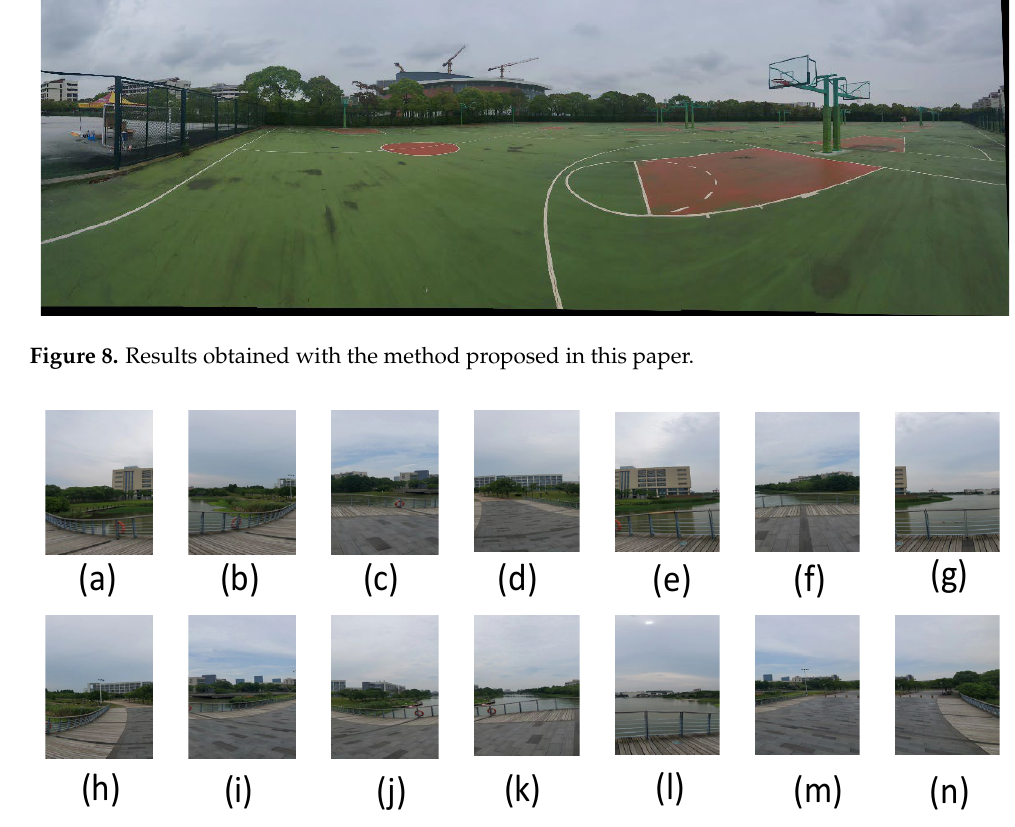
Figure 9. ( a – n ) are the experimental image s of scene 2.